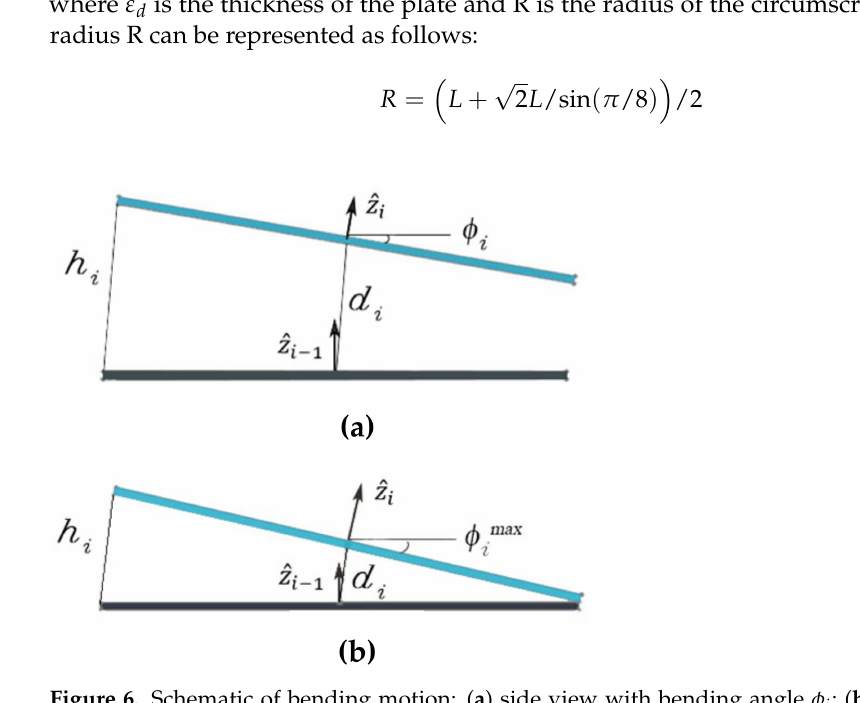
Figure 6. Schematic of bending motion: ( a ) side view with bending angle φ i ; ( b ) side view with maximum bending angle φ max . i